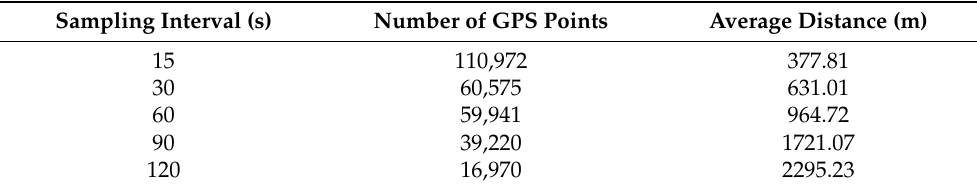
Table 2. Trajectory data information at different sampling frequencies. Sampling Interval